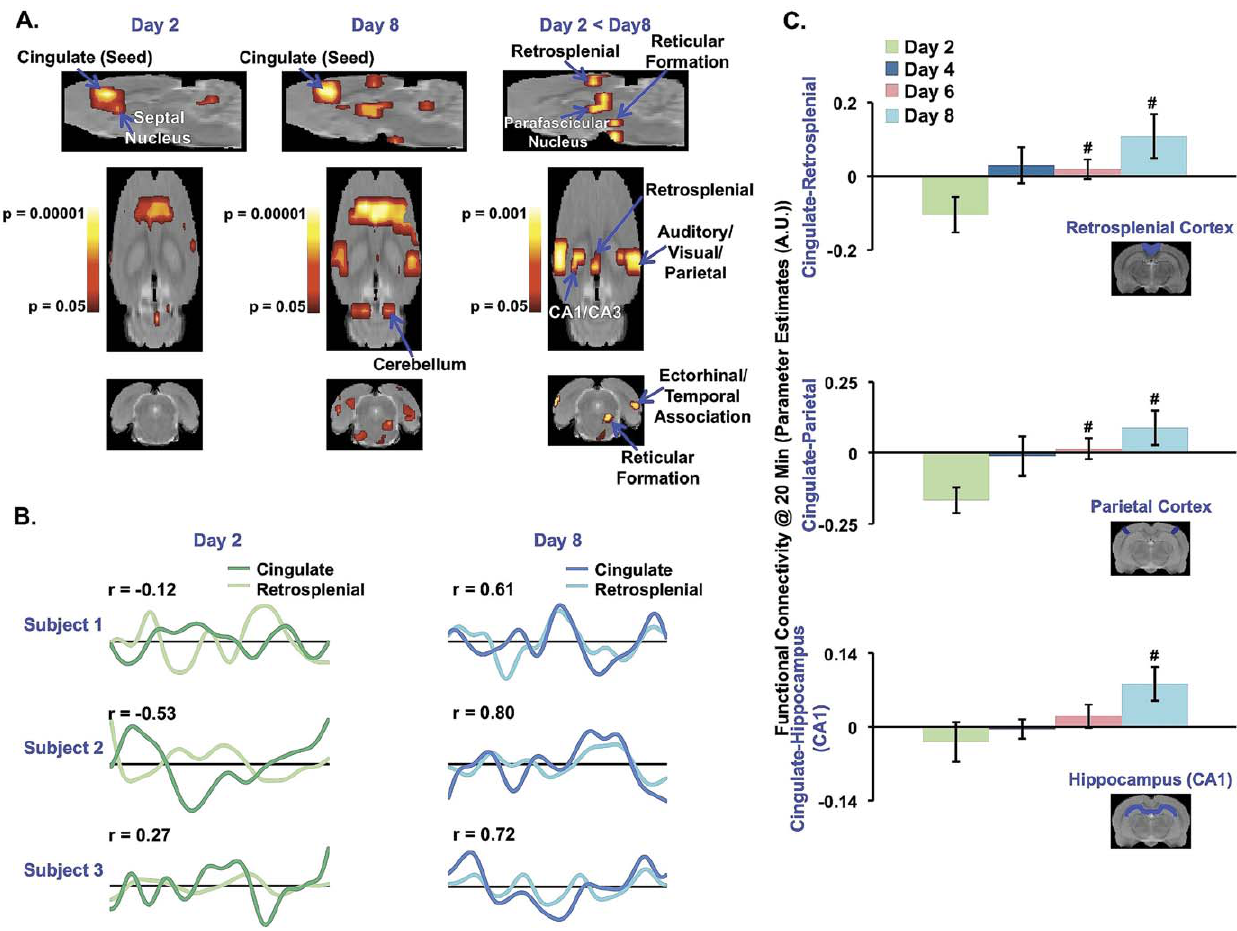
Figure 2. Presence of DMN-like Activity in Awake Rodents. A. At Day 2, seed region (anterior cingulate cortex) functional connectivity analysis did not yield CNS circuitry indicative of the DMN, but rather circuitry mediating anxiety ( Figure 3 ). CNS circuitry reflective of the DMN emerged at Day 8, when animals were more habituated to the MRI environment. All modeling and estimation of within-group (Day 2 and Day 8) and between- group (Day 2 , Day 8) functional connectivity with the anterior cingulate cortex was performed using mixed-effects analysis. Cluster size correction for all activation maps was also performed. All statistical maps are superimposed upon an in-house, high-resolution rat anatomical template. B. Time courses demonstrate increased coherence between cingulate and retrosplenial cortices at Day 8. C. An increasing trend in functional connectivity between the cinguate cortex and three other DMN structures was observed between Days 2-8. The ANOVA test for the three functional interactions quantified in C. were significant for cingulate-retrospenial (F 3,22 =3.69, p=0.027) and cingulate-parietal (F 3,22 =4.44, p=0.014) but not for cingulate-CA1 (F 3,22 =2.57, p=0.080). Two-tailed, t-test were also implemented for specific pairwise comparisons (cingulate-retrosplenial- Day 4 : t 10 =-1.92, p=0.084; Day 6 : t 12 =-2.26, p=0.043; Day 8 : t 12 =-2.79, p=0.016). (cingulate- parietal- Day 4 : t 10 =-1.96, p=0.078; Day 6 : t 12 =-3.09, p=0.0093; Day 8 : t 12 =-3.34, p=0.0059). (cingulate-CA1- Day 4 : t 10 =-0.51, p=0.62; Day 6 : t 12 =-1.13, p=0.28; Day 8 : t 12 =-2.23, p=0.045). All error bars represent s.e.m. Day 2 (N=7); Day 4 (N=5); Day 6 (N=7); Day 8 (N=7). # p , 0.05. splenial interaction with respiratory rates (R =-0.095, P= 0.66) or head motion (R = 2 0.22, p = 0.28) was not detected.